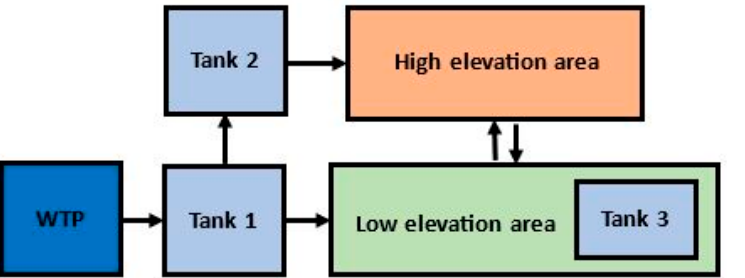
Figure 2. Schematic representation of the connections between main components in the considered system.